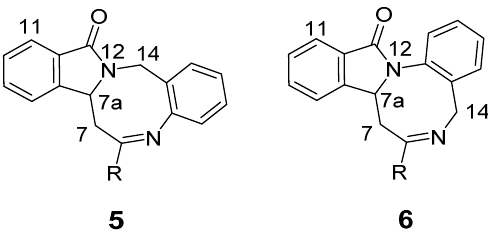
Figure 3. Potential reaction products formed.